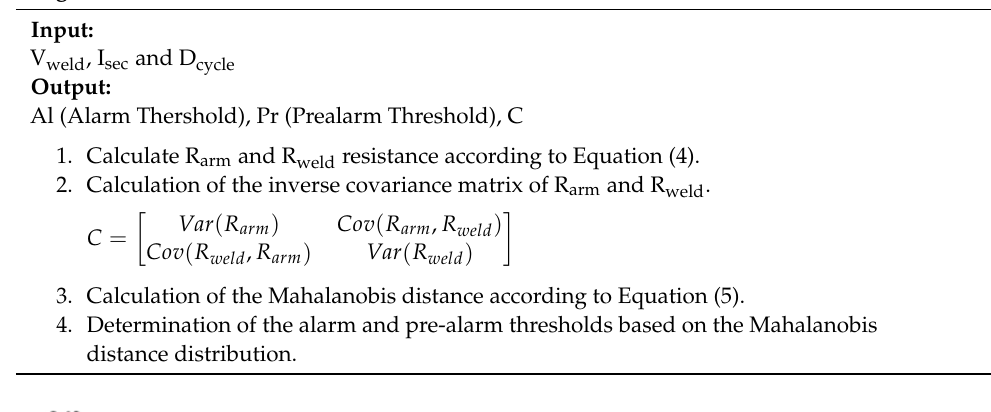
Figure 9. Comparison of the average minimum distance between the points and the closest thresh- old for the Euclidean distance and the Mahalanobis distance.